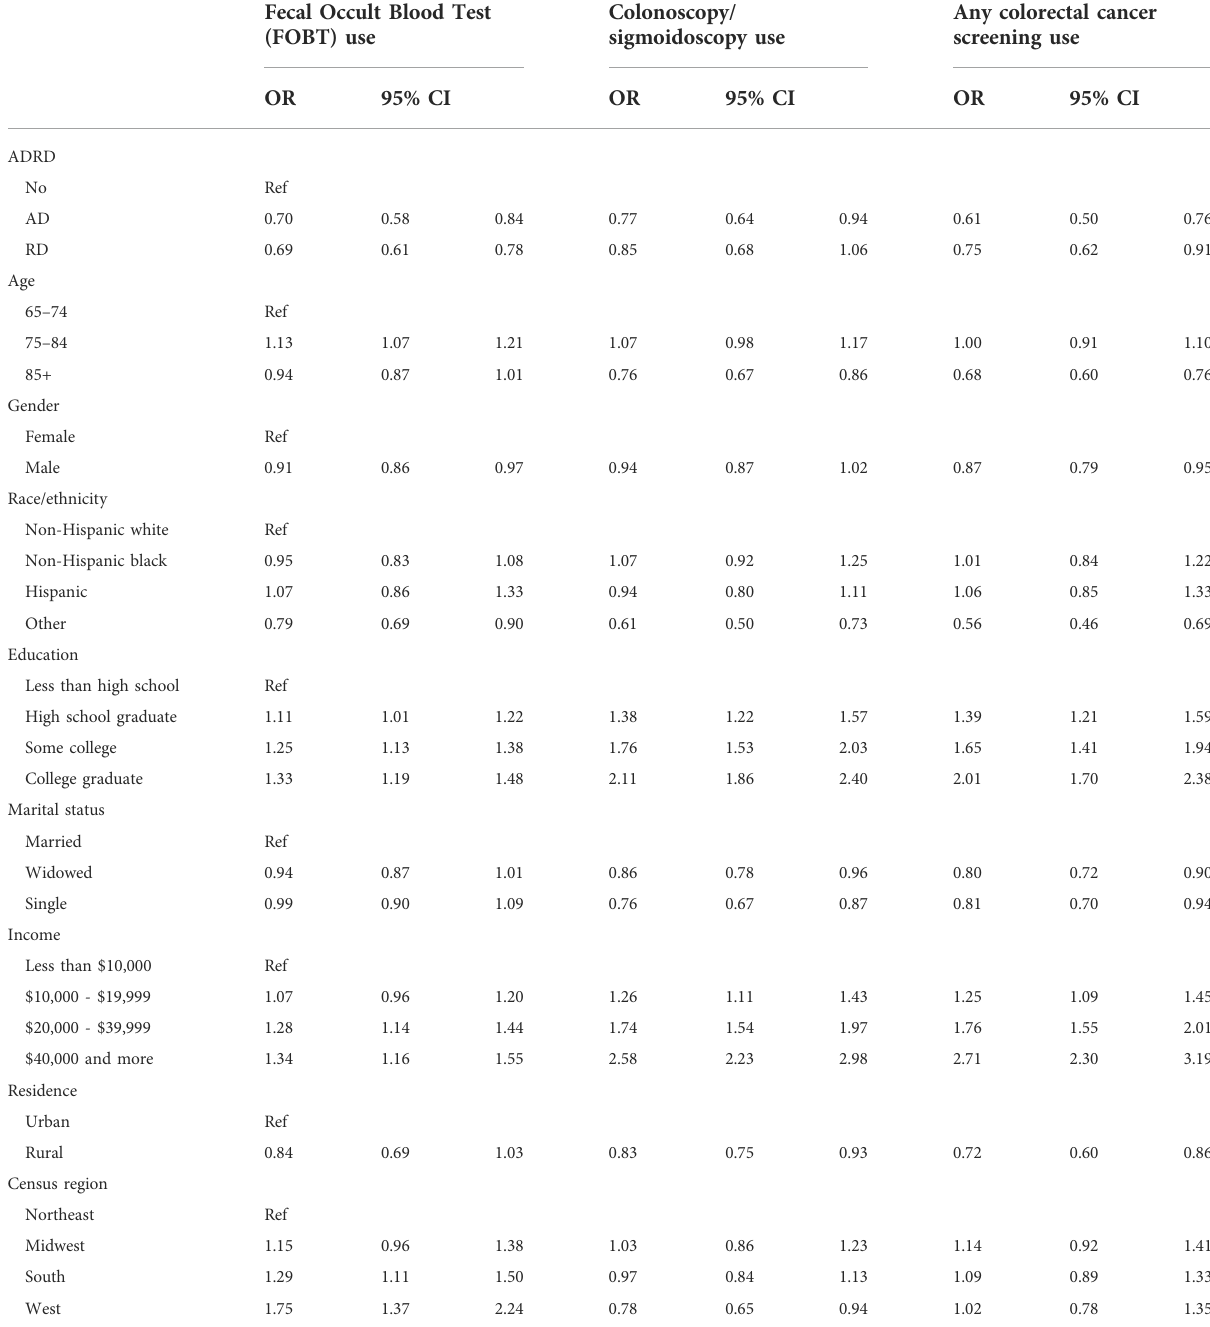
TABLE 2 Factors associated with colorectal cancer screening use. Fecal Occult Blood Test (FOBT)